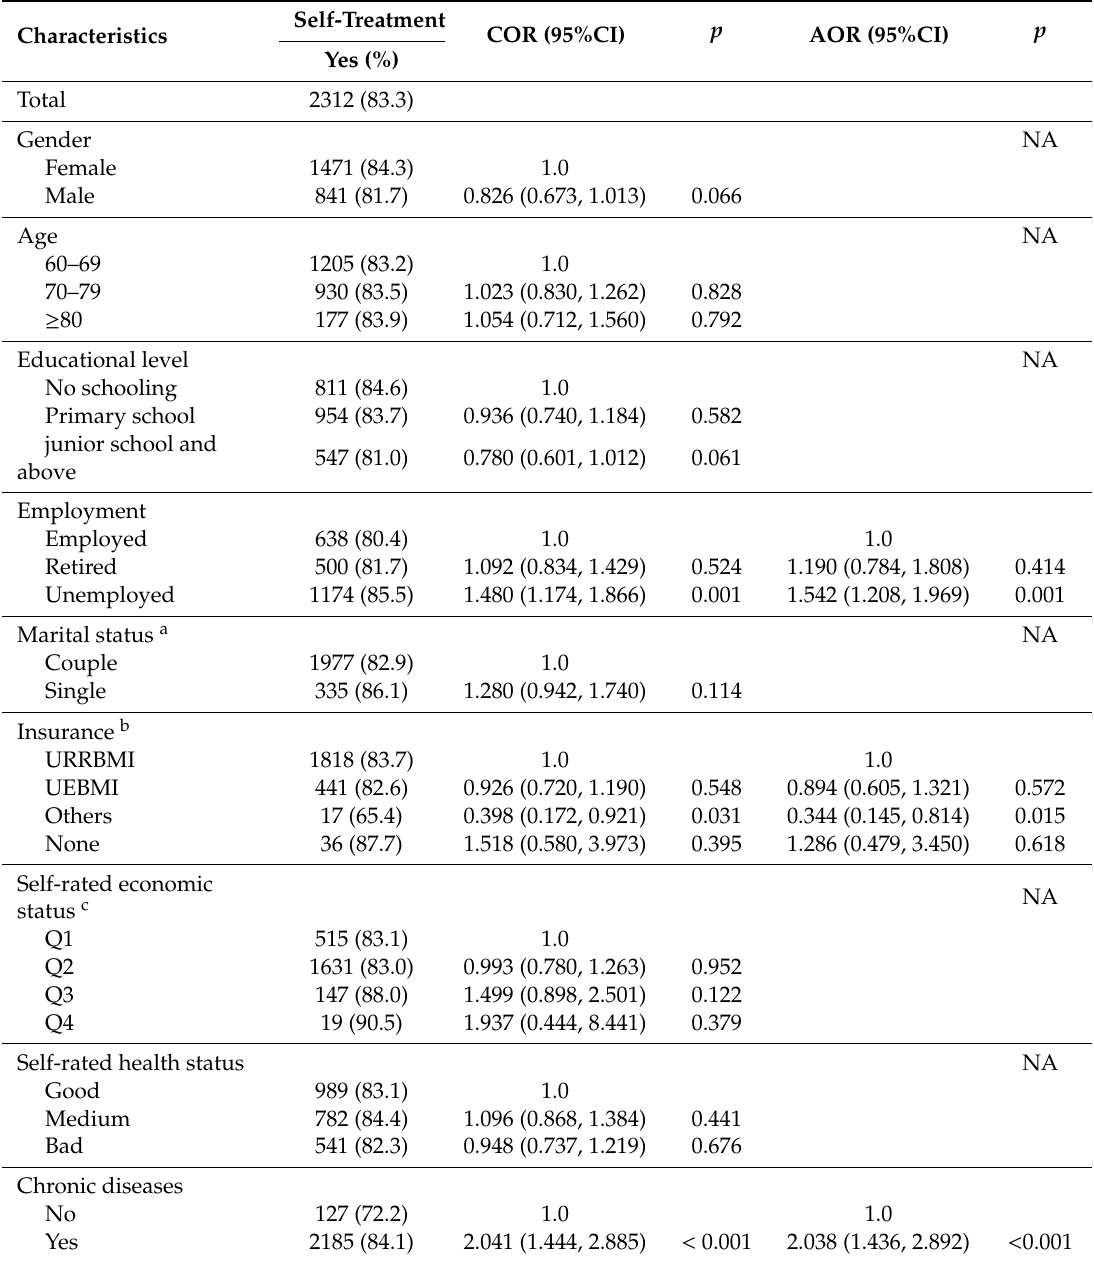
Table 4. Factors with self-treatment among non-empty nesters in Shandong. China. ( n = 2774).